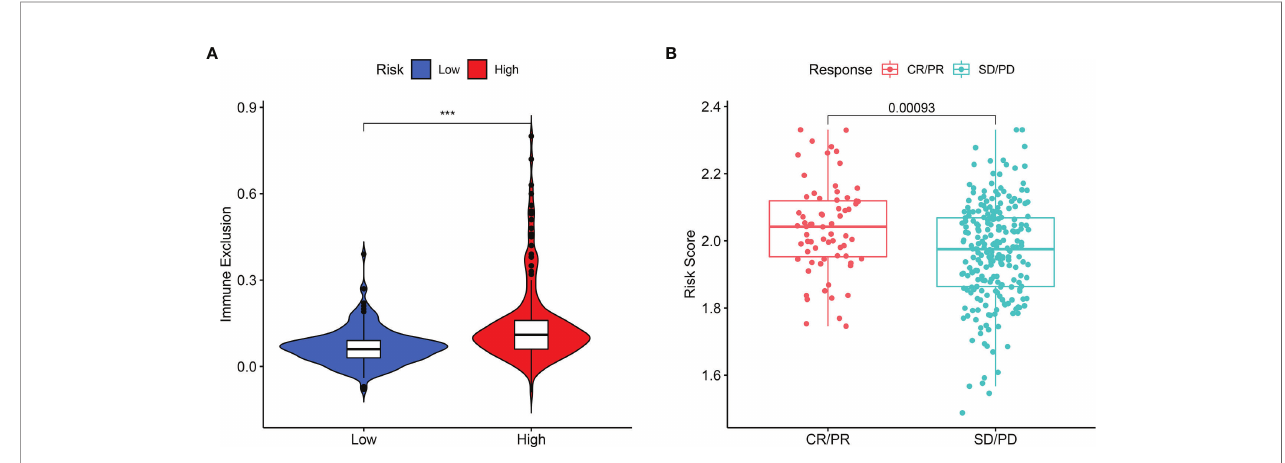
FIGURE 6 | The difference in immune exclusion between high- and low-risk groups and the distribution of risk scores in immunotherapy response group. (A) Immune exclusion levels in two subgroups. (B) Distribution of risk scores in the distinct anti ‐ PD ‐ 1 clinical response group. P values were showed as: ns, not signi fi cant; *P < 0.05; **P < 0.01; ***P <